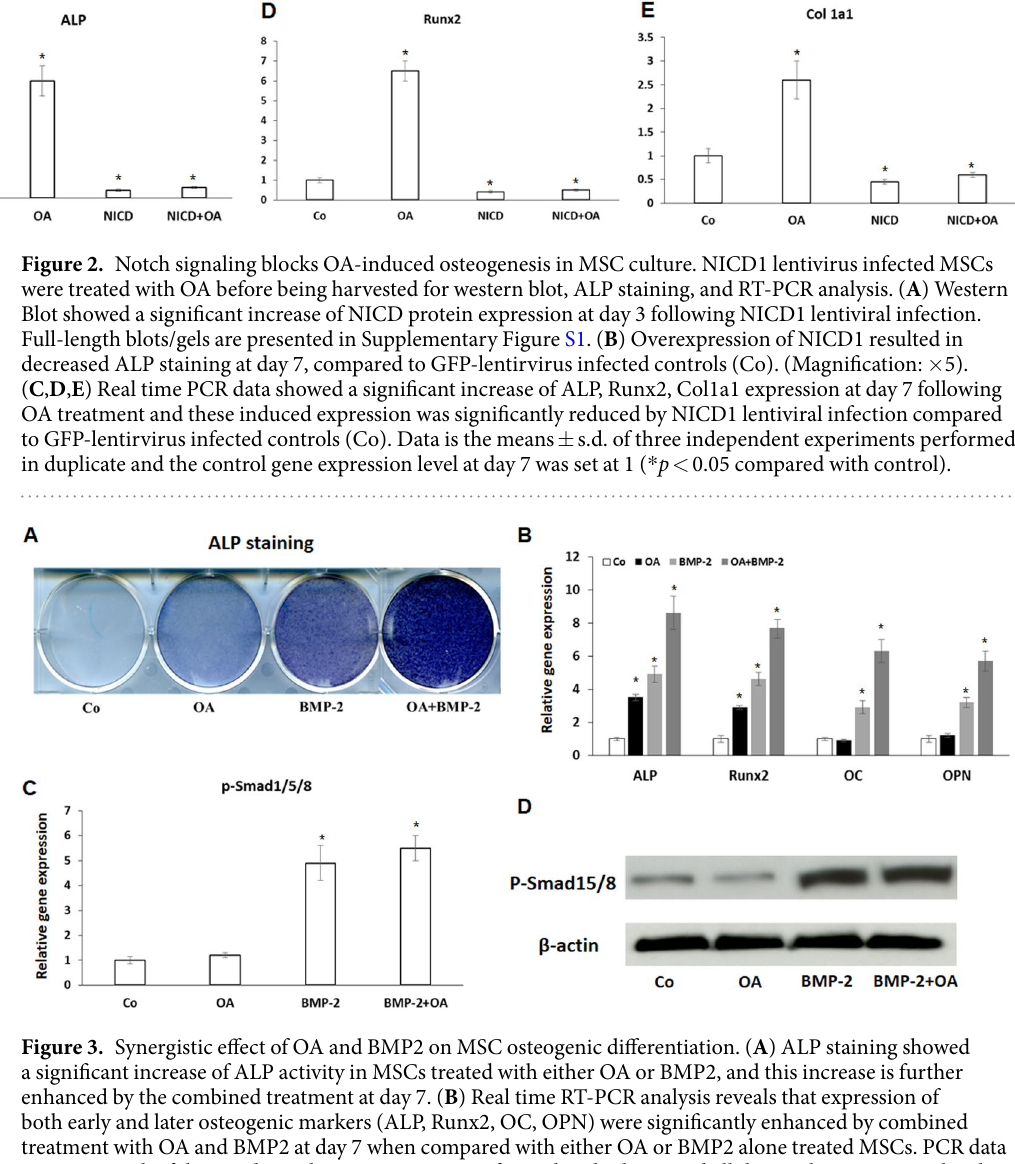
Fractures and bone defects are common in both military and civilian populations with over 2.2 million bone repair surgeries worldwide each year 26 . This bone repair process is regulated by multiple molecular cascades